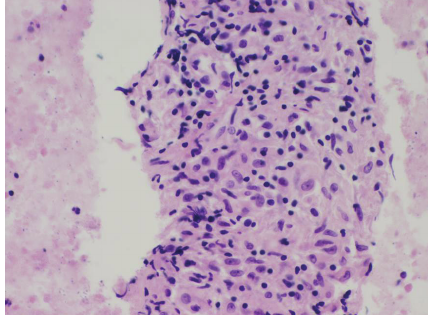
Figure 1: Acomplex cystic mass with thick-walled irregular septa- tions indenting the head of the pancreas (arrow), mimicking the appearance of a cystic neoplasm.